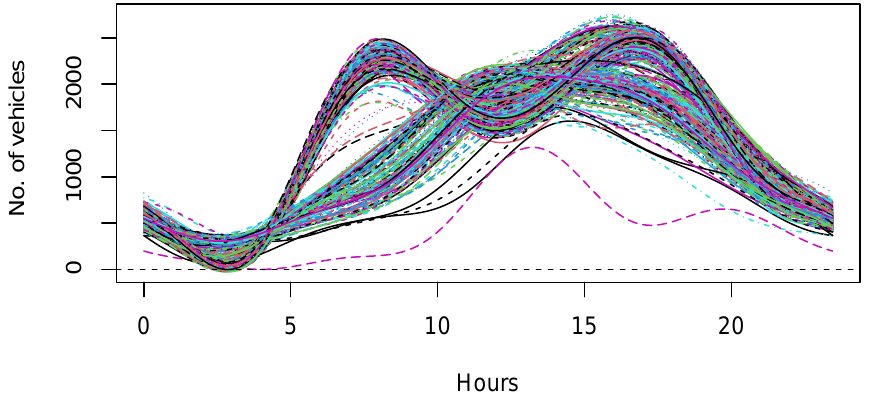
Figure 2. Daily traffic flow curves for the period